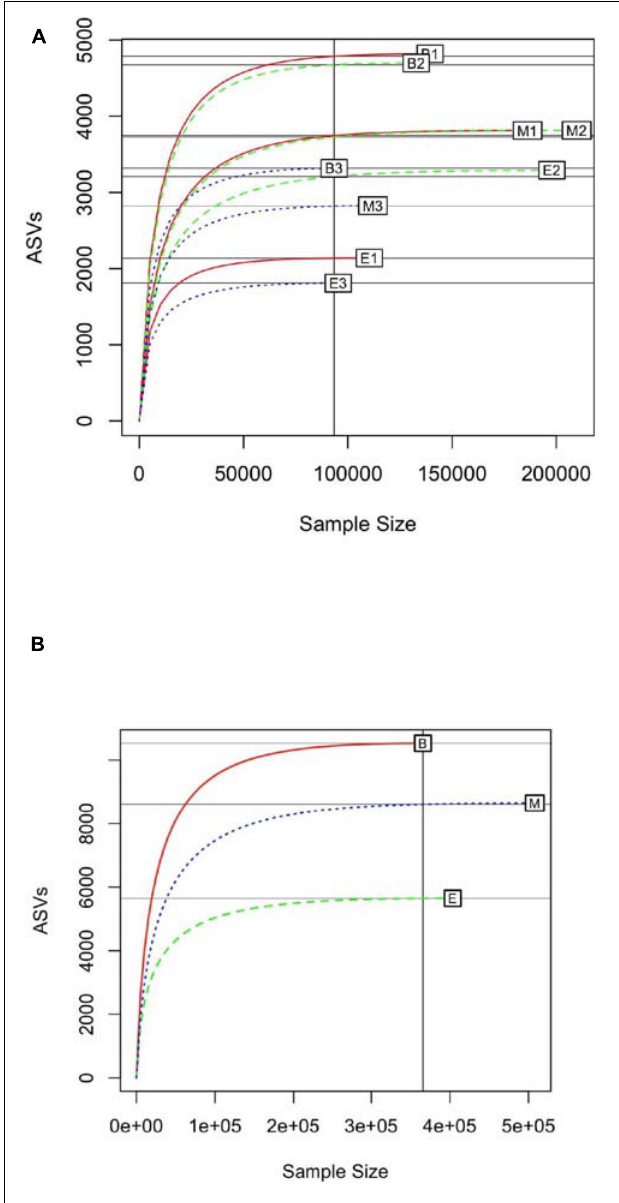
FIGURE 3 | (A) Rarefaction curve of 16S prokaryote sequences detected by three universal prokaryote primers (341b4_F/806_R, N341b4_F/806_R, and Pro341F/Pro805R) in Bhomra (freshwater), EKW (sewage-fed), and Malencho (brackish-water) wetlands. The abbreviations and numerics used are as follows: B, Bhomra; E, EKW; M, Malencho; 1, 341b4_F/806_R; 2, N341b4_F/806_R; 3, Pro341F/Pro805R; EKW, East Kolkata wetland. (B) Rarefaction curve of 16S prokaryote sequences detected in three wetland sediments (Bhomra, EKW, and Malencho). The data are pooled over three primers in each wetland. The abbreviations used are as follows: B, Bhomra; E, EKW; M,